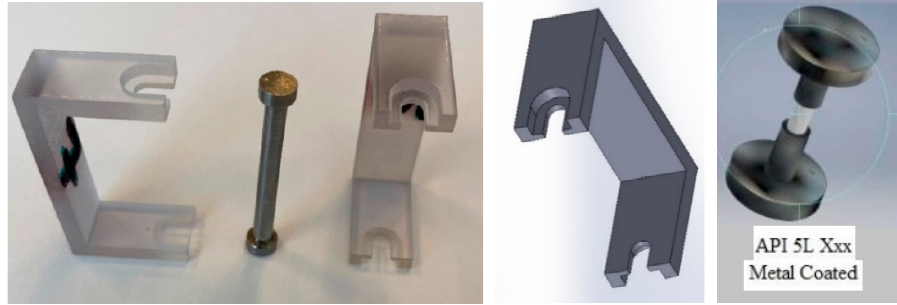
Figure 1. The 3D ‐ printed external corrosion detection sensor and its CAD model. Figure 1. The 3D-printed external corrosion detection sensor and its CAD